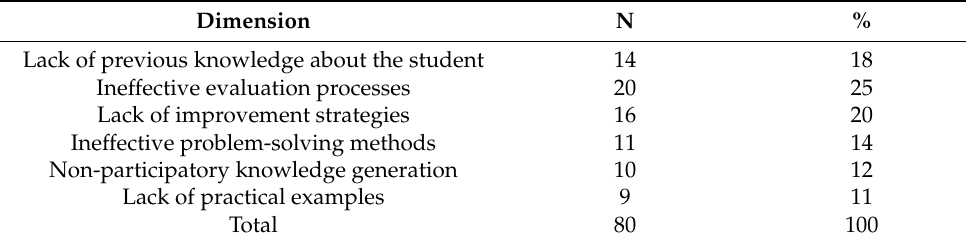
Table 4. Pedagogical difficulties of